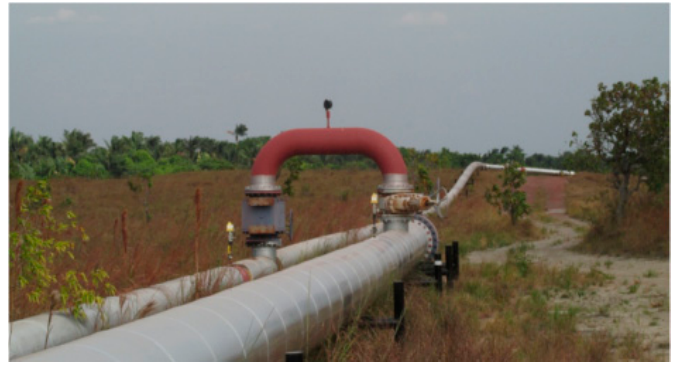
Figure 1. Loop in pipelines of heavy crude oil.